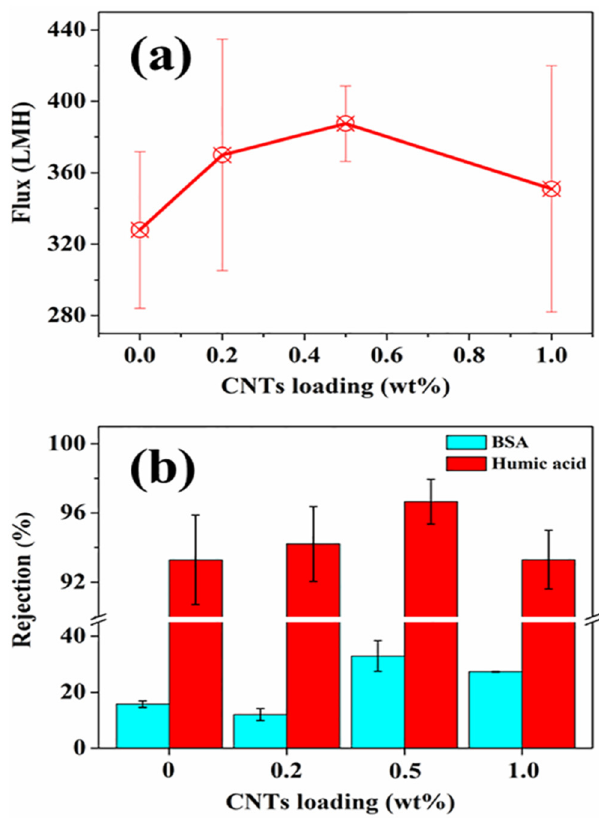
Figure 6. ( a ) Flux and ( b ) rejection of alumina/polymer hollow fibre membranes with different CNTs